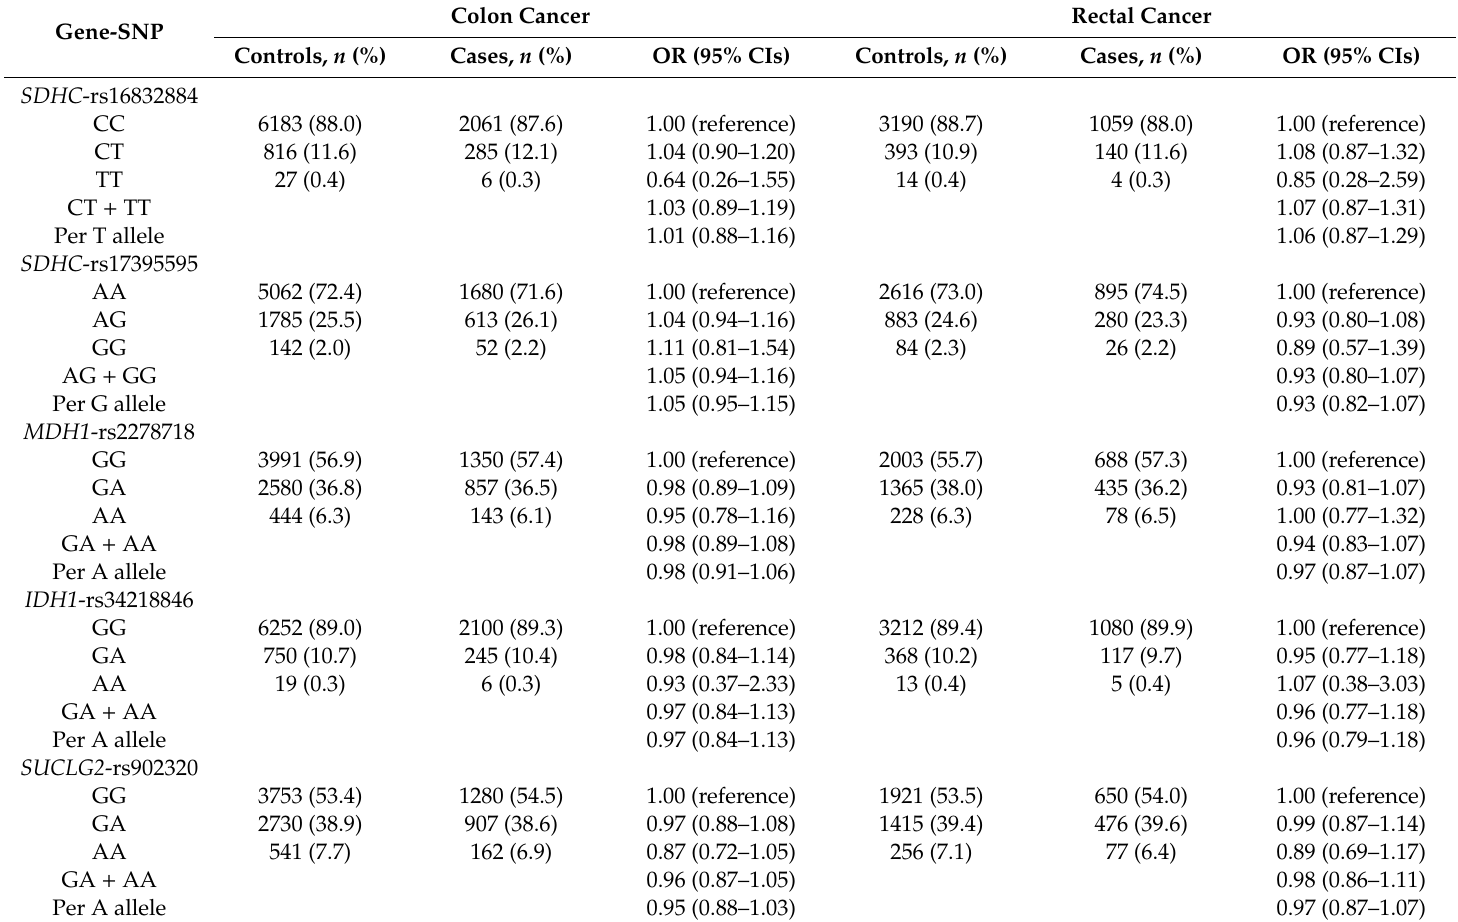
Table 3. Odds ratios (OR) and 95% confidence intervals (CIs) of the association of citric acid cycle SNPs with the risk of colorectal cancer by